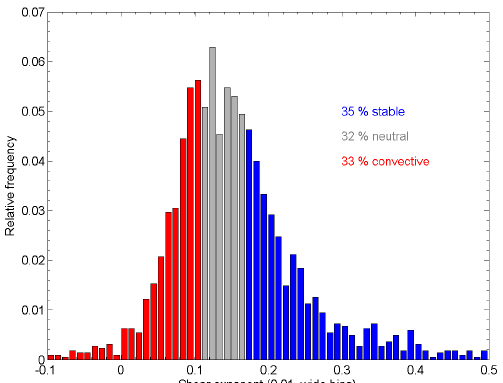
Figure 16. Shear exponent distribution using thresholds in Table 2. Includes data filtered for tower 80m wind speeds between 3.5 and 25.0ms − 1 , 87m wind directions between 235 and 315 ◦ , and for normal turbine